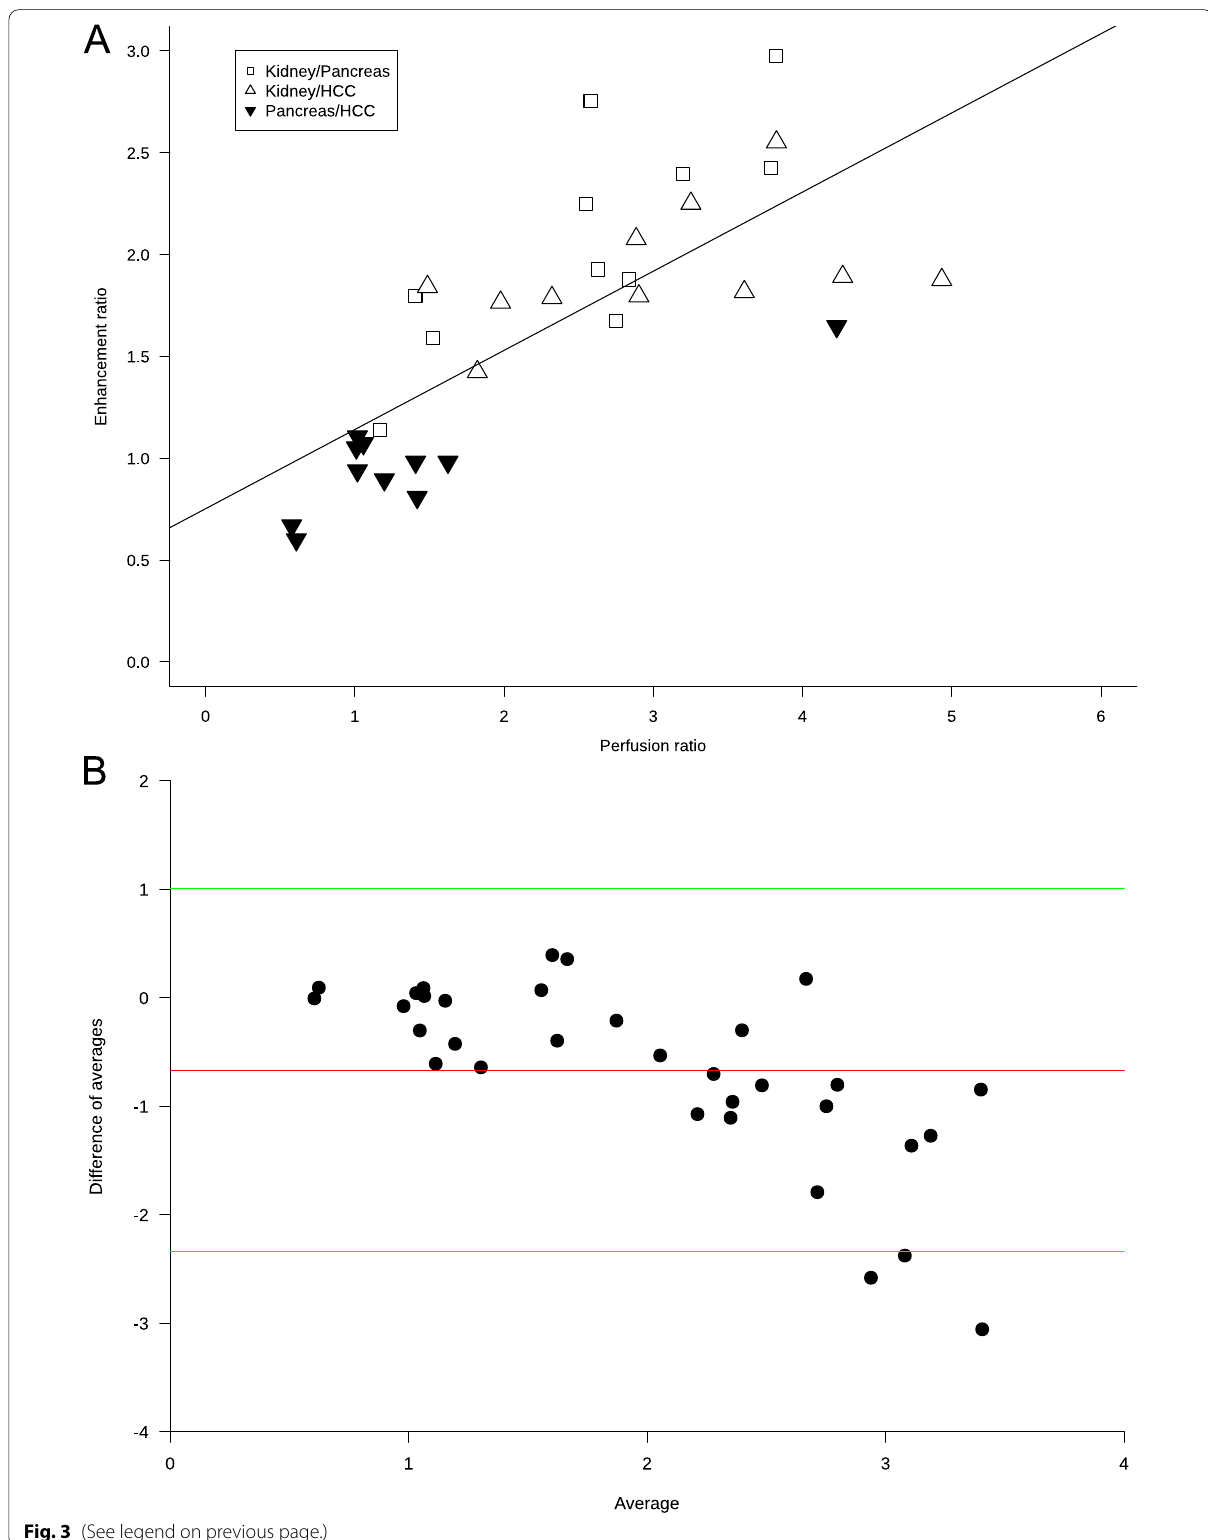
Fig. 3 (See legend on previous